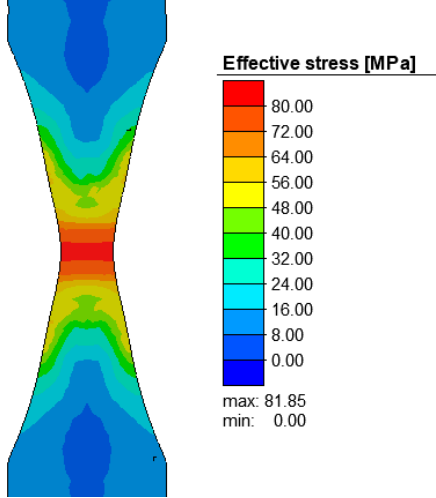
Figure 9. Effective stress (MPa) in the axial section of the R200 steel sample under the tensile test at 1100 °C.